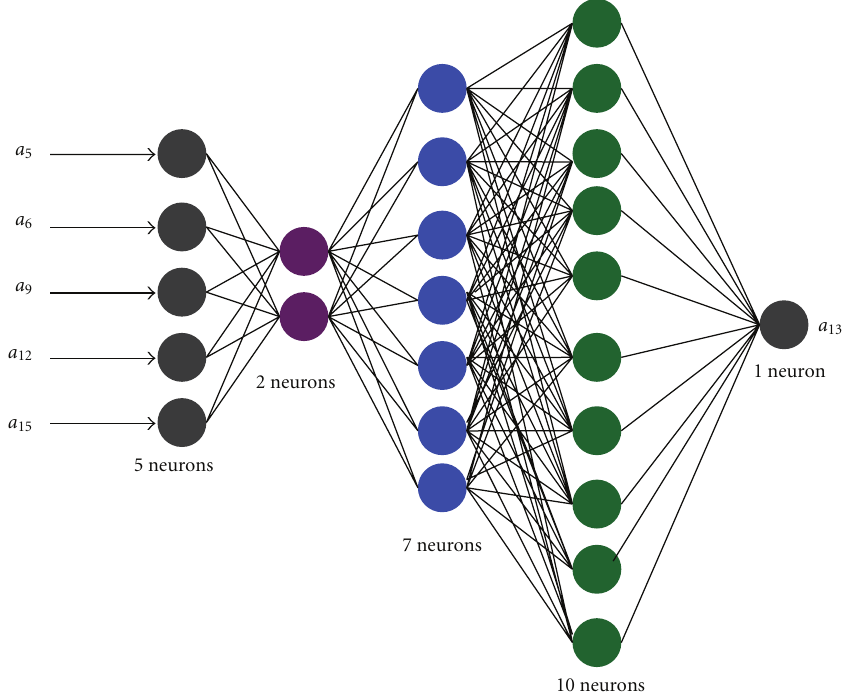
Figure 8: Optimal ANN for damage detection using the neural-wavelet